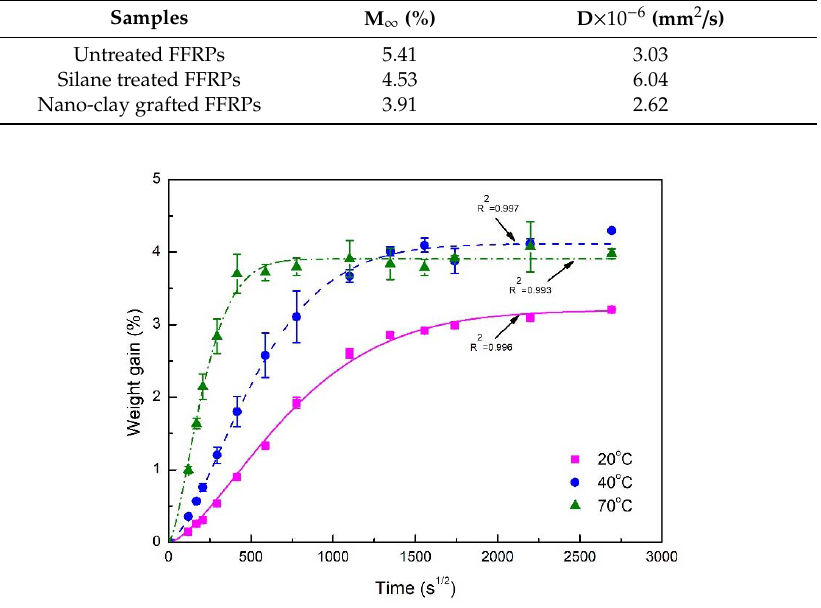
Table 2. Maximum water uptake and di ff usion coe ffi cient (D) of FFRPs at 70 ◦ C under 80% RH.